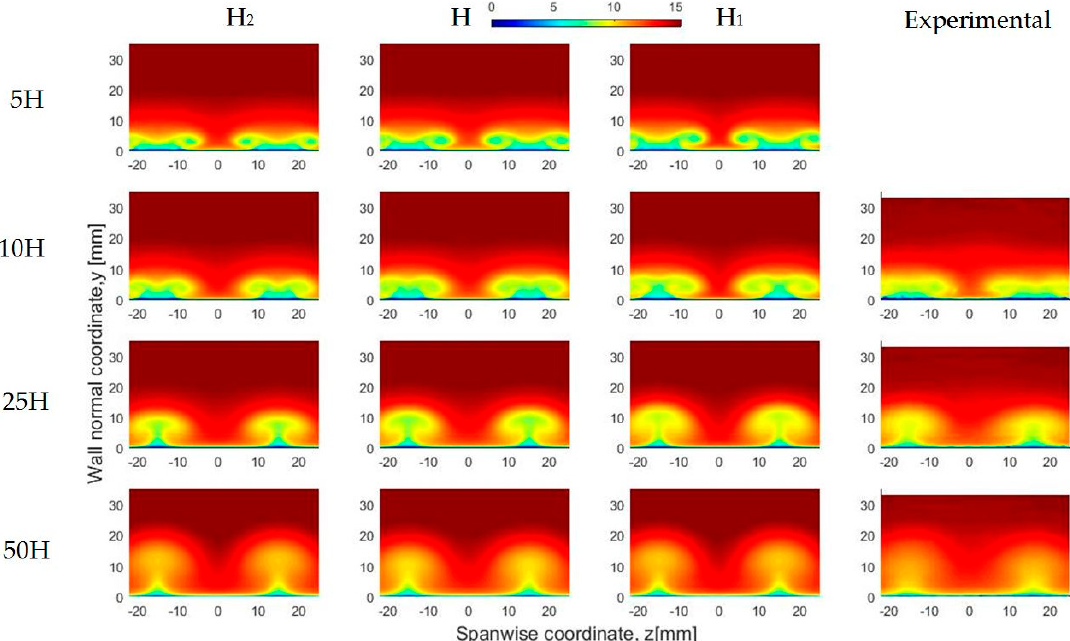
Figure 8. Comparison of the out-of-plane streamwise velocity fields u x between experimental and numerical simulations of the three cases H, H 1 and H 2 . Streamwise plane positions from top to bottom: 5H, 10H, 25H, 50H.